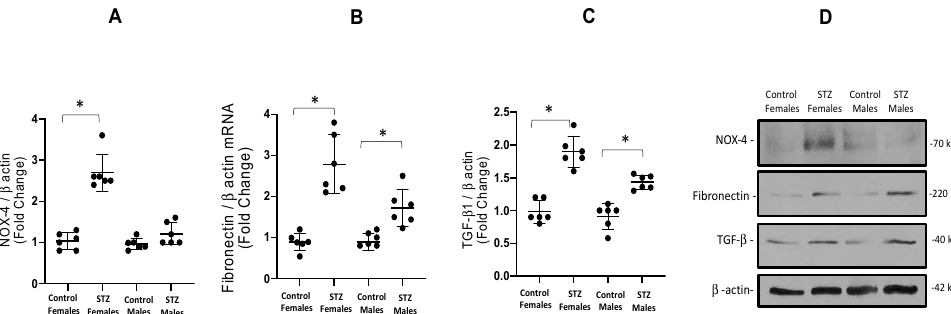
Figure 4. Protein expression of NOX-4, fibronectin and TGF- β 1. ( A ). NOX-4 was augmented in STZ females, while males had no significant change. Protein abundances of fibronectin was augmented in both males and females ( B ). Similarly, TGF- β 1 was also augmented in both STZ male and female mice ( C ). A representative blot from 4 – 6 experiments is shown in D. * p < 0.05 vs. control group.